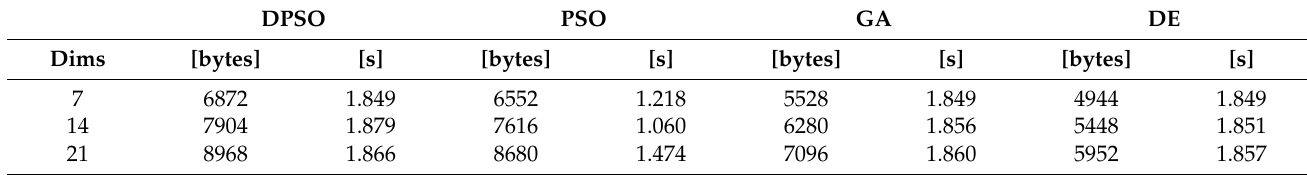
Table 5. The Computational costs in terms of average memory and time for each dimension size on the elliptical